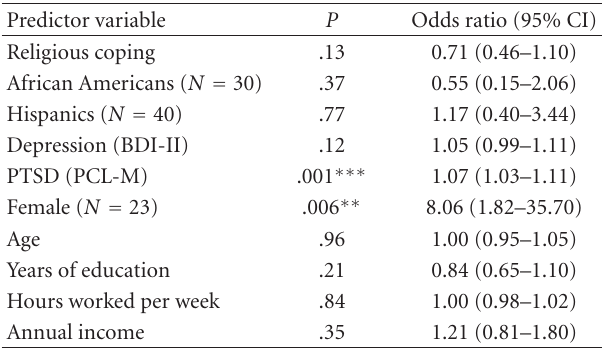
Table 8: Logistic regression with religious coping as a predictor of use of specialty mental health